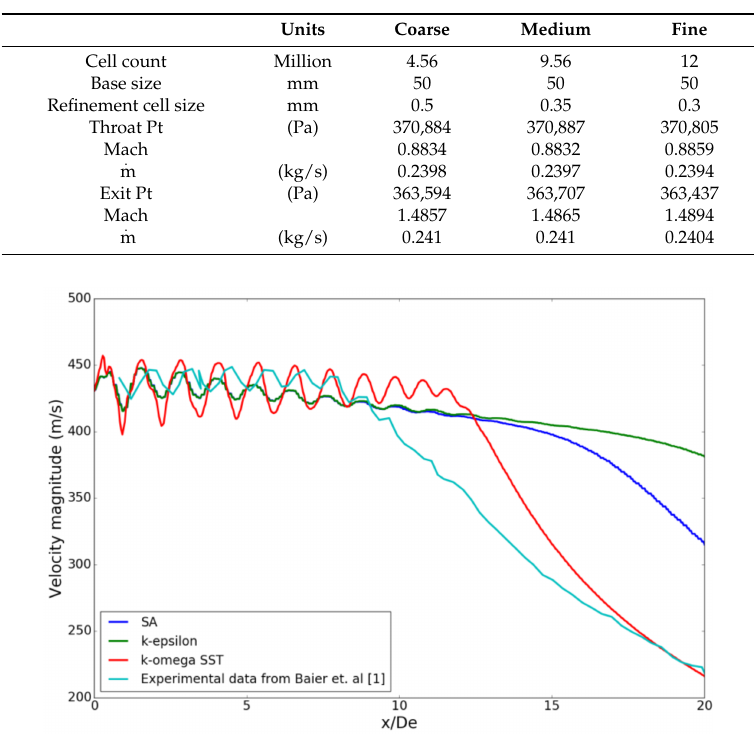
Figure 3. Turbulence model